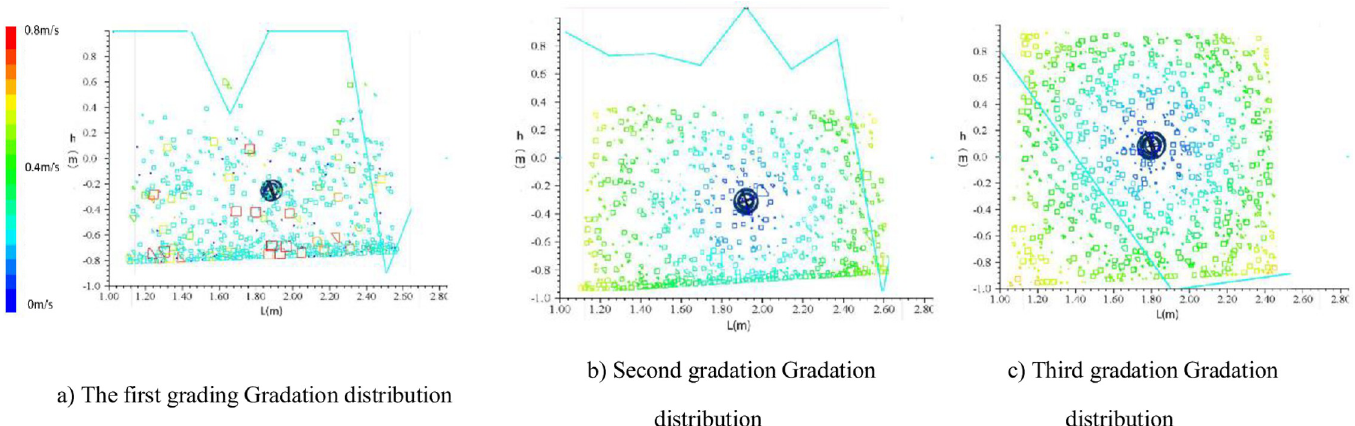
Fig 6. Gradation distribution after disturbance and migration distance record of particle 1. a) The first grading Gradation distribution, b) Second gradation Gradation distribution, c) Third gradation Gradation distribution.